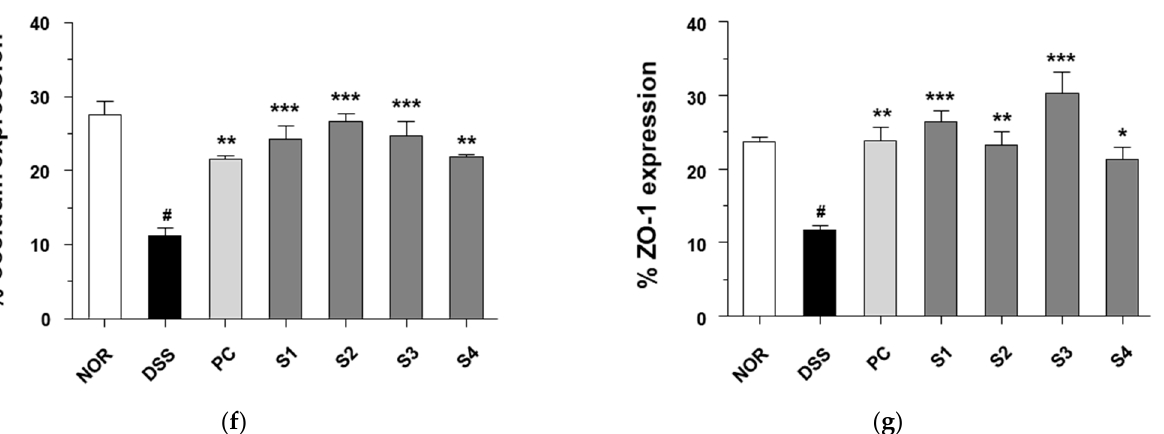
Figure 6. Effect of Cheonggukjang on the expression of mucins and tight junction protein in DSS- induced colitis mice: ( a ) Representative Alcian blue staining images of colon tissue. The abundance of goblet cells and mucin production was determined. Magnification (200×), Scale bar; 50 μ m; mRNA levels of ( b ) Muc2 and ( c ) Muc3 were analyzed by quantitative real-time PCR; ( d , e ) Representative immunohistochemistry images of colon tissue. Magnification (200×), Scale bar, 50 μ m; ( f , g ) Quantification of occludin and ZO-1 expression by IHC. Values are presented as the mean ± SD (n = 5); #, p < 0.005 versus normal group; ***, p < 0.001; **, p < 0.005; *, p < 0.05 versus DSS group.